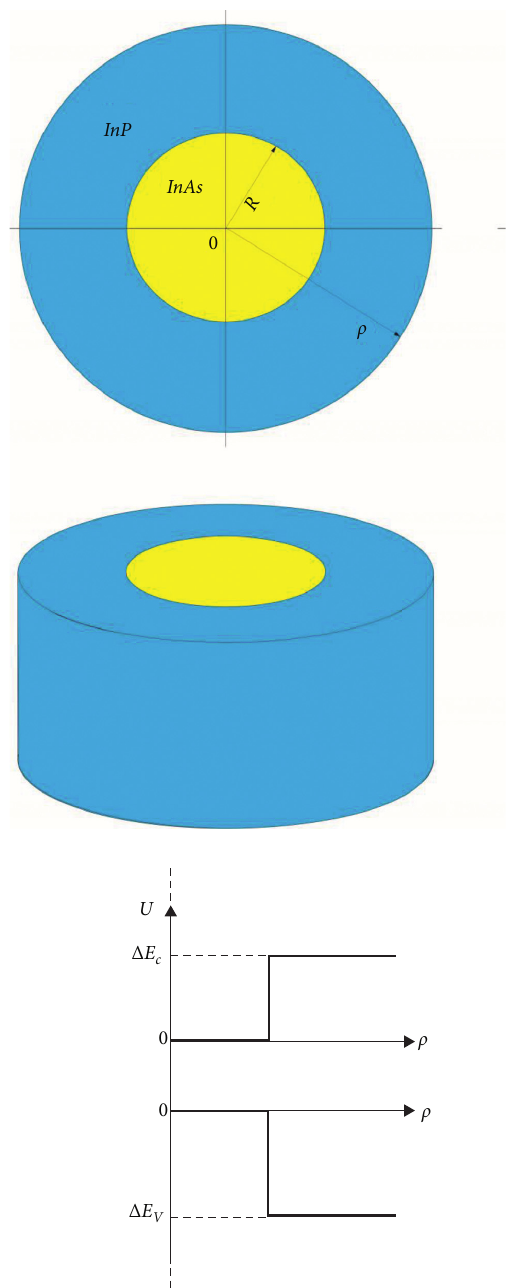
Figure 1: Geometric and potential diagram of a cylindrical quantum wire with a finite potential